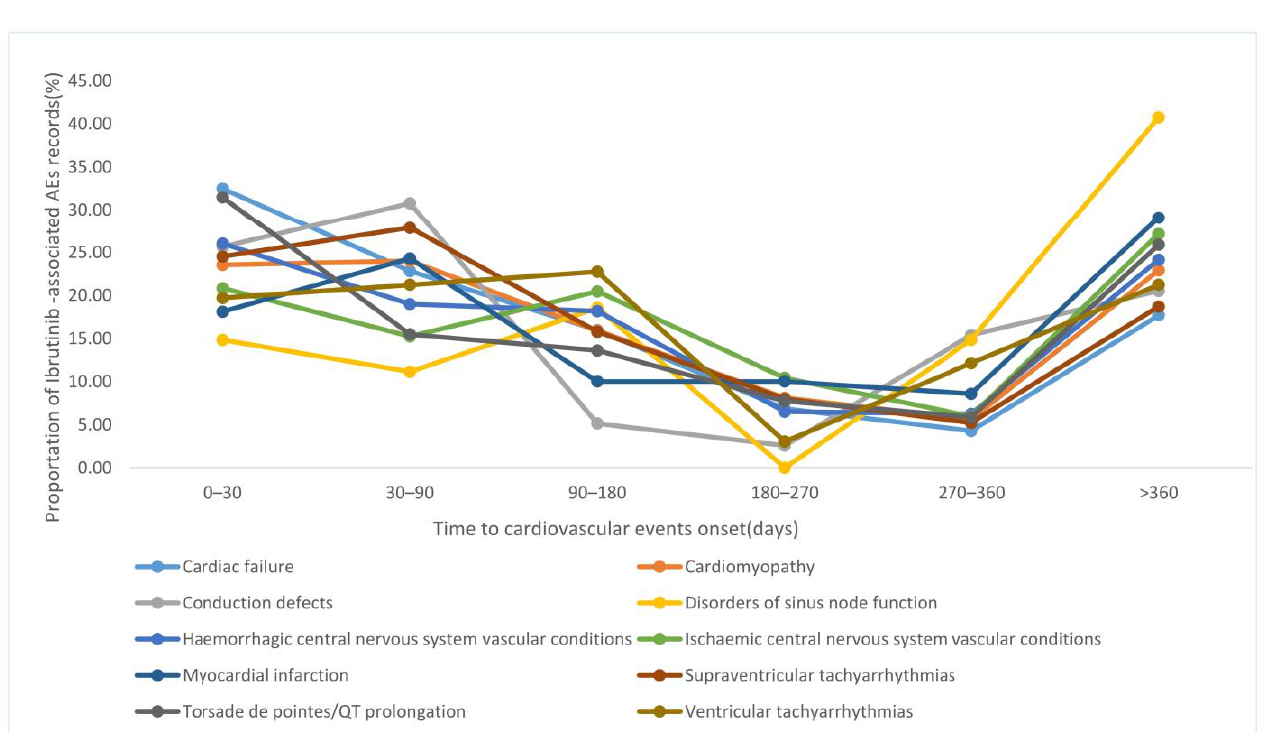
Figure 3. Time to onset for 10 cardiovascular toxicities.